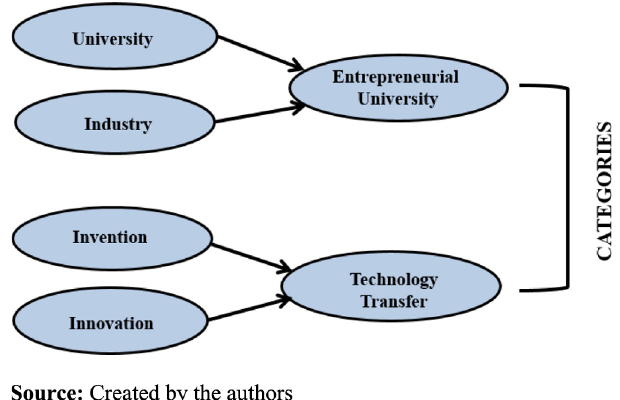
Figure 1. Analysis